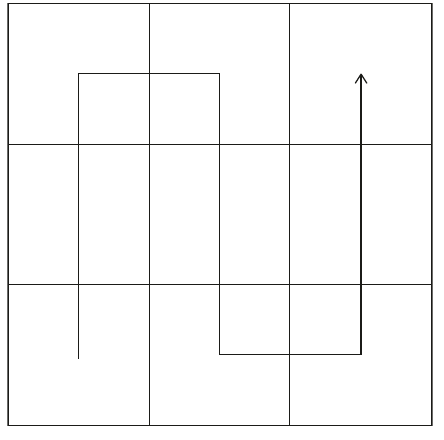
Figure 1: Filling curve path 1.